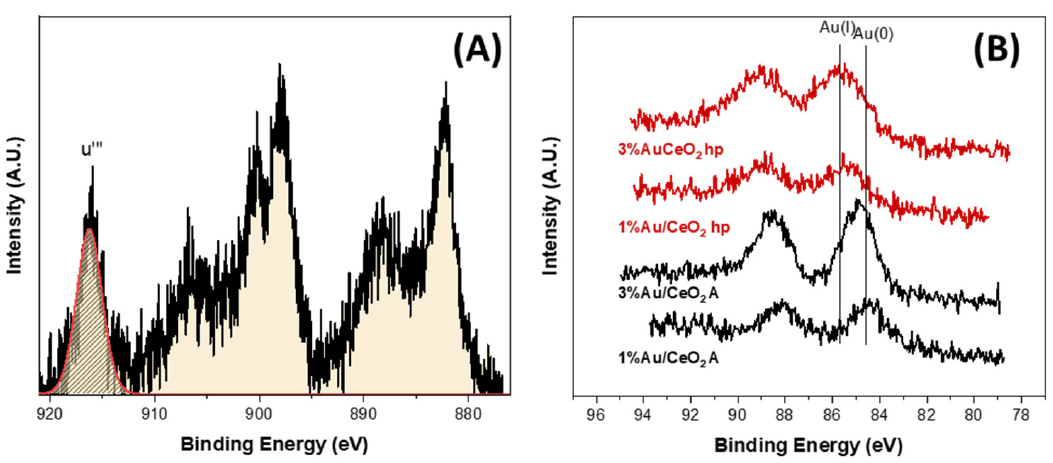
Table 2. XPS data of the two series of Au/Ceria catalysts in terms of Ce(III)/Ce(IV) percentages, Au 4f5/2 binding energy and Au/Ce atomic ratios. The values calculated by EDX and the nominal Au/Ce ratios are reported for comparison.